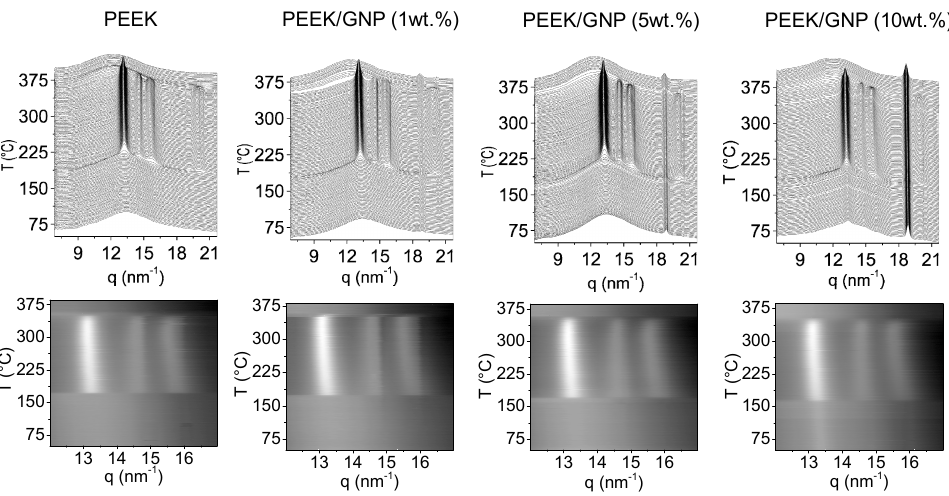
Figure 7. Simultaneous time-resolved WAXS patterns ( upper ) and intensity profiles of three main PEEK diffractions ( down ) for crystallization from glass (cold crystallization) for PEEK and PEEK/GNP